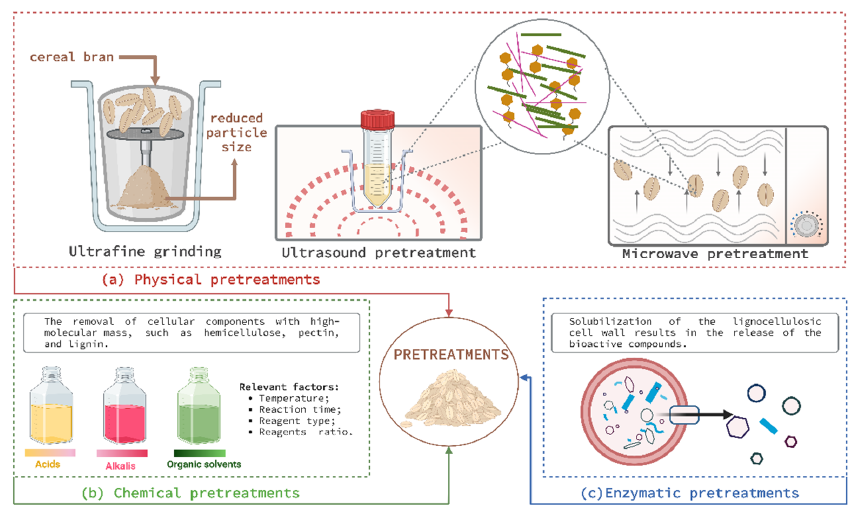
Figure 3 . Key pretreatments for cereal bran processing . Figure 3. Key pretreatments for cereal bran